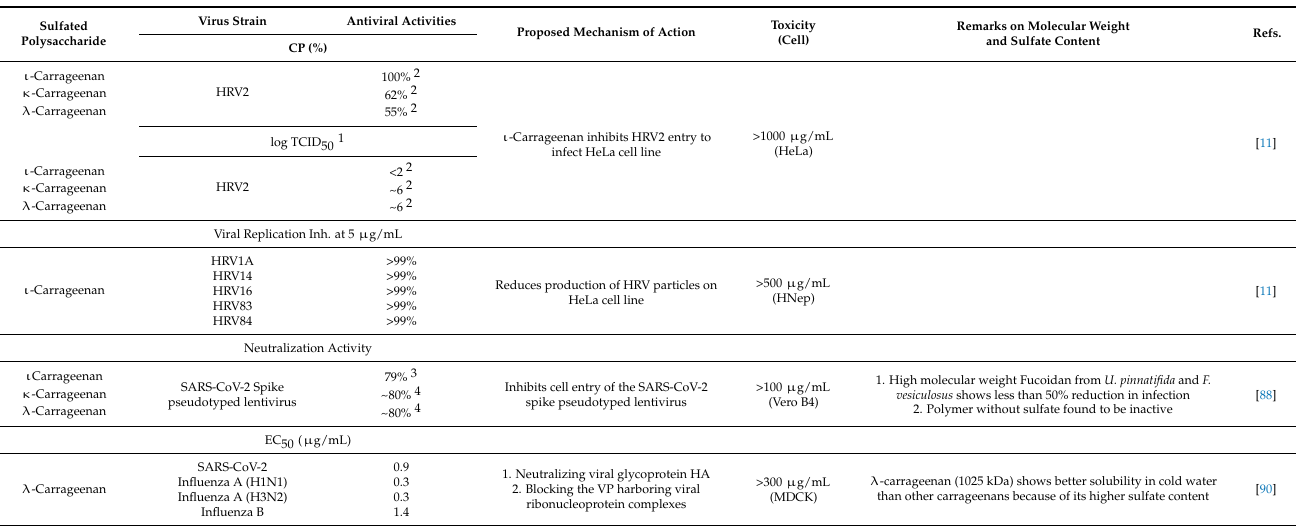
Figure 8. Proposed mechanism of action against viral infection on ( A ) the virion entry; ( B ) inhibition of spike protein binding to ACE2 by complex formation of sulfated polysaccharides-ACE2, ( C ) ionic interaction between the negatively charged sulfate group and spike protein inhibit the formation of spike protein binding to ACE2, ( D ) sulfated polysaccharides inhibition on viral particle replication, indicated by the red arrow, ( E ) inhibition on neuraminidase to prevent assembled viral particle to be released, indicated by red arrow. Mechanisms B and C are proposed for the inhibition against SARS-CoV-2 by [84,88,91]. Mechanisms D and E are proposed from the finding on NDV by [92] and influenza A virus by [12]. Adapted from (Hans, et. al., 2021) and (Frediansyah, 2021). Table 3. Summary of antiviral activity among carrageenans with each respective proposed mechanism of action and remarks on molecular weight and sulfate content of the tested